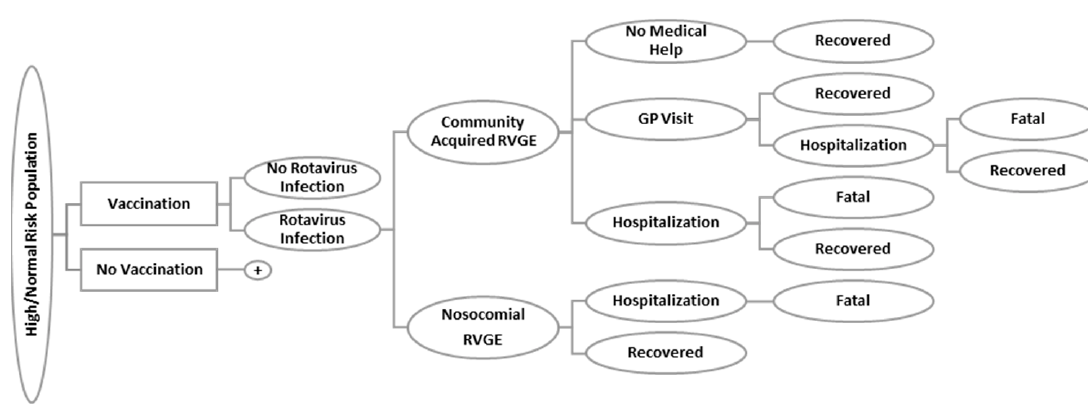
Figure 1. Schematic structure of the age-structured deterministic cohort model: the covered and non-covered patients (vaccination/no-vaccination) are both at risk of acquiring rotavirus infection in community or hospital (nosocomial). The infection can lead to complications in which the patient will stay at home (no medical help), visit the GP, or become hospitalized. The probability of dying because of rotavirus infection is only included within the cases who are hospitalized. The “no vaccination” arm is the same as the “vaccination” arm (+), except that different probabilities apply. The population considered can be at normal or high risk for rotavirus infection. GP, general practitioner; RVGE, rotavirus